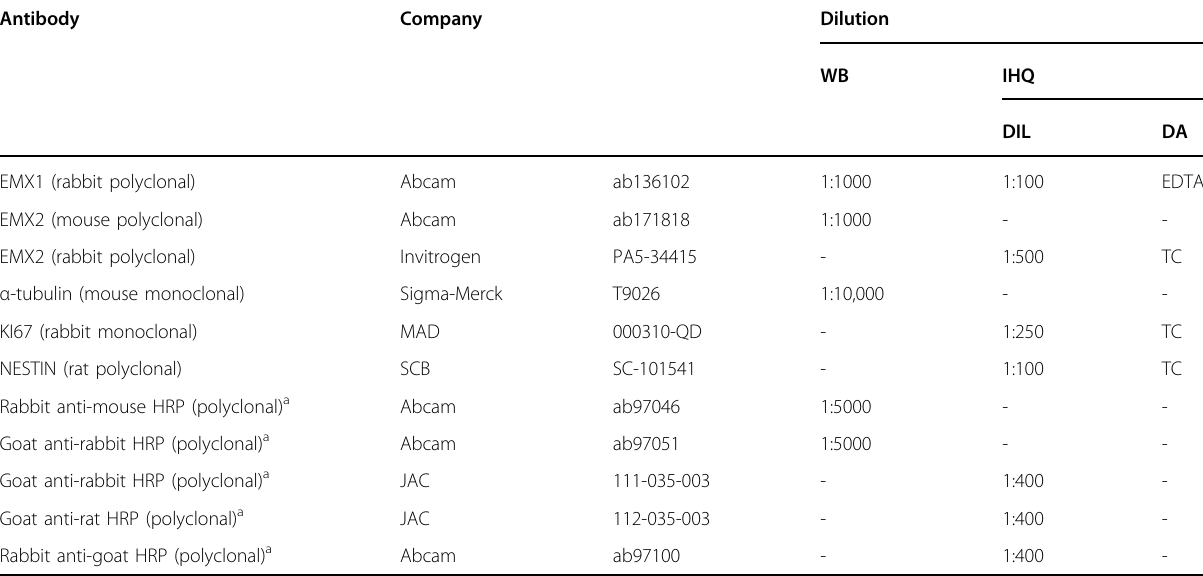
Table 4 Antibodies used in this study. Antibody